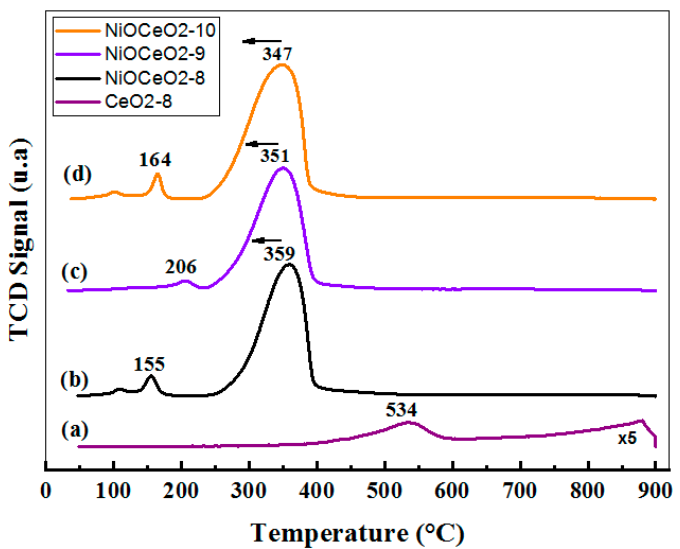
Figure 2. TPR profiles (H 2 consumption) for samples CeO 2 -8 ( a ), NiOCeO 2 -8, ( b ) NiOCeO 2 -9 ( c ) and NiOCeO 2 -10 ( d ).